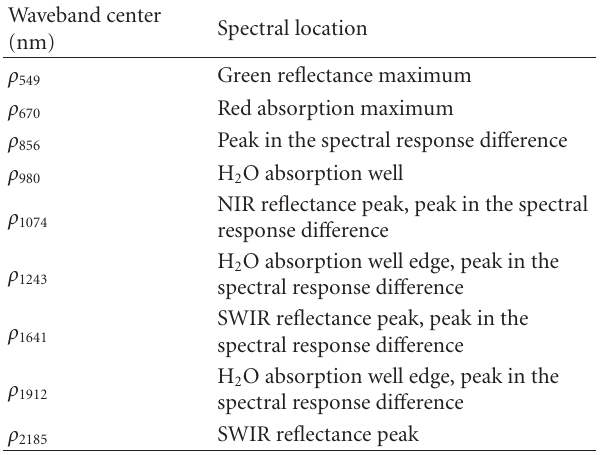
Table 2: Narrow spectral wavebands available for selection in the stepwise discriminant analysis.